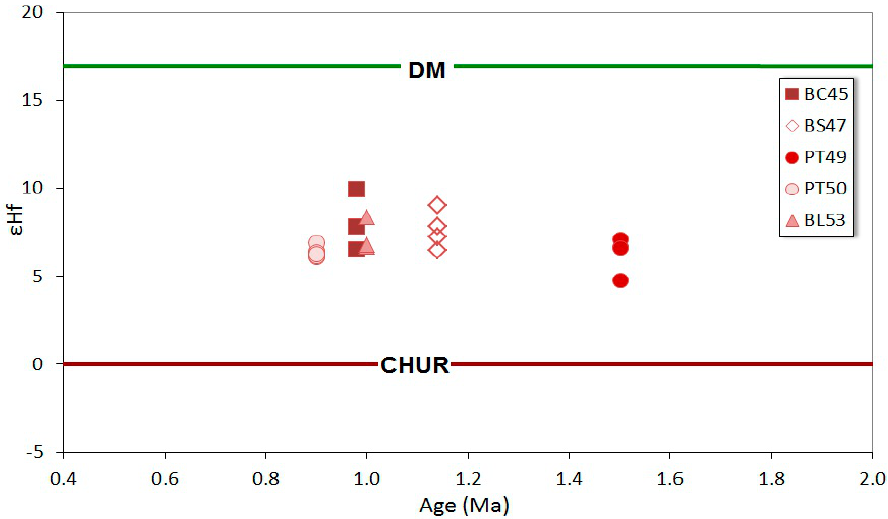
Figure 13. U-Pb Age (Ma) versus ε Hf for RVP zircon. CHUR: Chondritic uniform reservoir, DM: Depleted mantle.